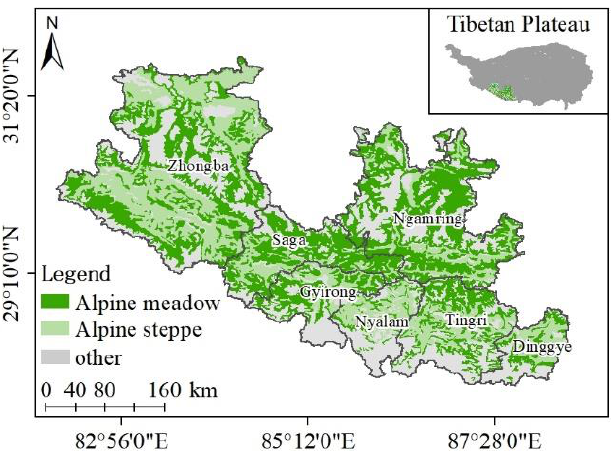
Figure 1. The location and vegetation types of the study area. The map was created using ESRI ArcMap 10.7 software; the topographic base of the map was created with National Catalogue Service For Geographic Information data (https://www.webmap.cn, figure number: GS(2016)2556); the vegetation map source from the CASEarth Data Sharing and Service Portal (http://data.casearth.cn, accessed on 19 December 2018).